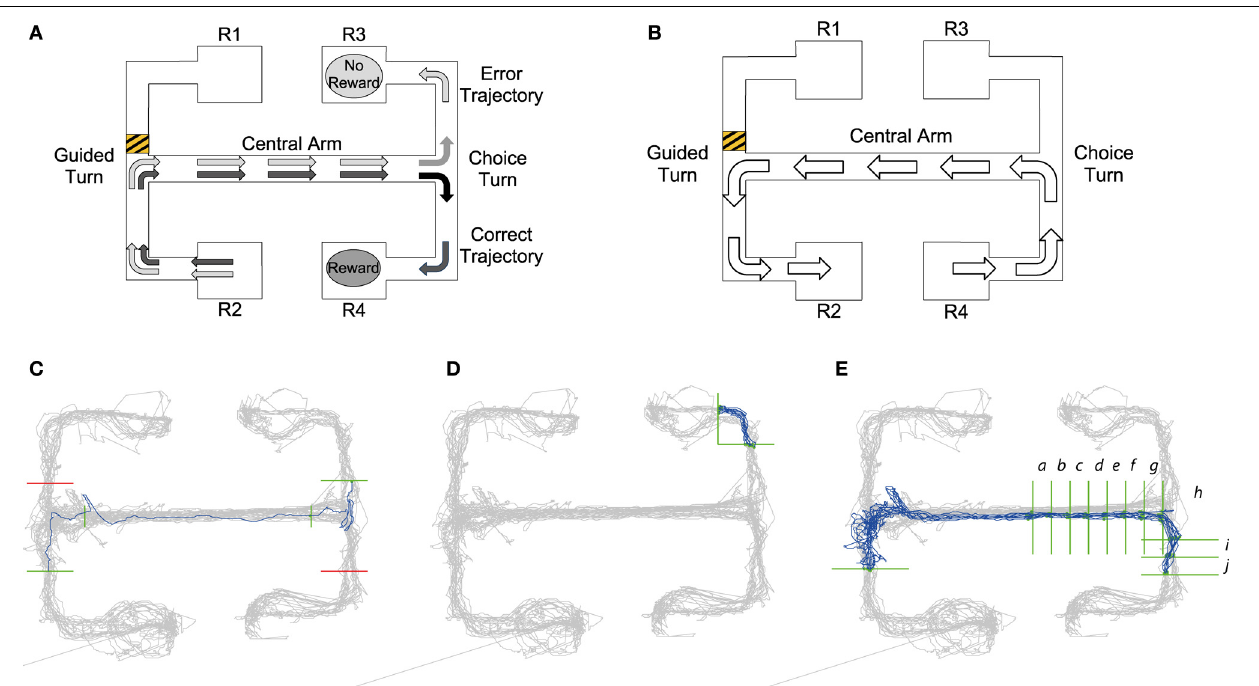
FIGURE 1 | (A) Visualization of choice trial starting at the R2 reward point. Black arrows demonstrate the trajectory of a “correct trial” consisting of two turns in the same direction resulting in a reward at reward point R4. Gray arrows show the trajectory of the “error trial” of two different turns resulting in no reward at reward point R3. (B) Guided trial starting at R4. The barrier placed in the upper left arm, shows that a trajectory from right to left starting at reward point R4 would result in a guided left turn. Panels (C–E) : Queries from MQL toolbox used to select specific trajectories from tracking data: Query lines are shown in green, avoid lines in red, all position data is shown in gray and trajectories